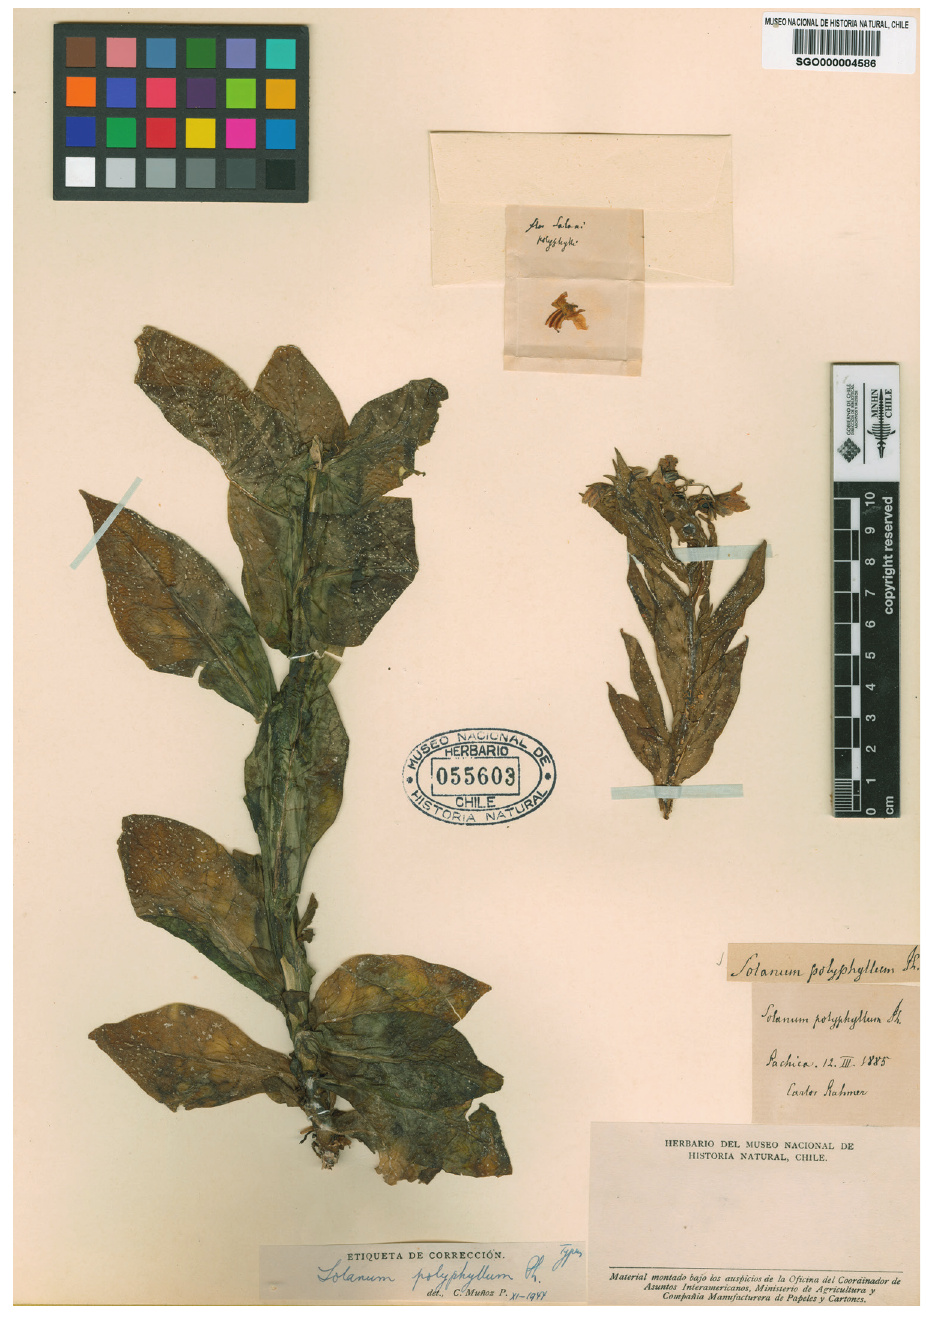
Figure 1. Solanum polyphyllum Phil. (lectotype: C. Rahmer s.n. , SGO000004586